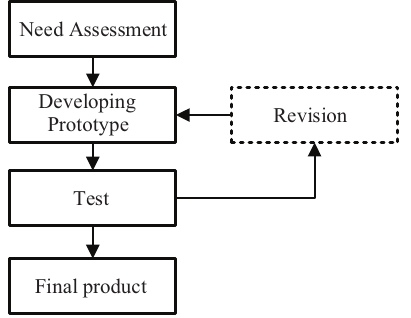
Figure 3. Prototype SDLC